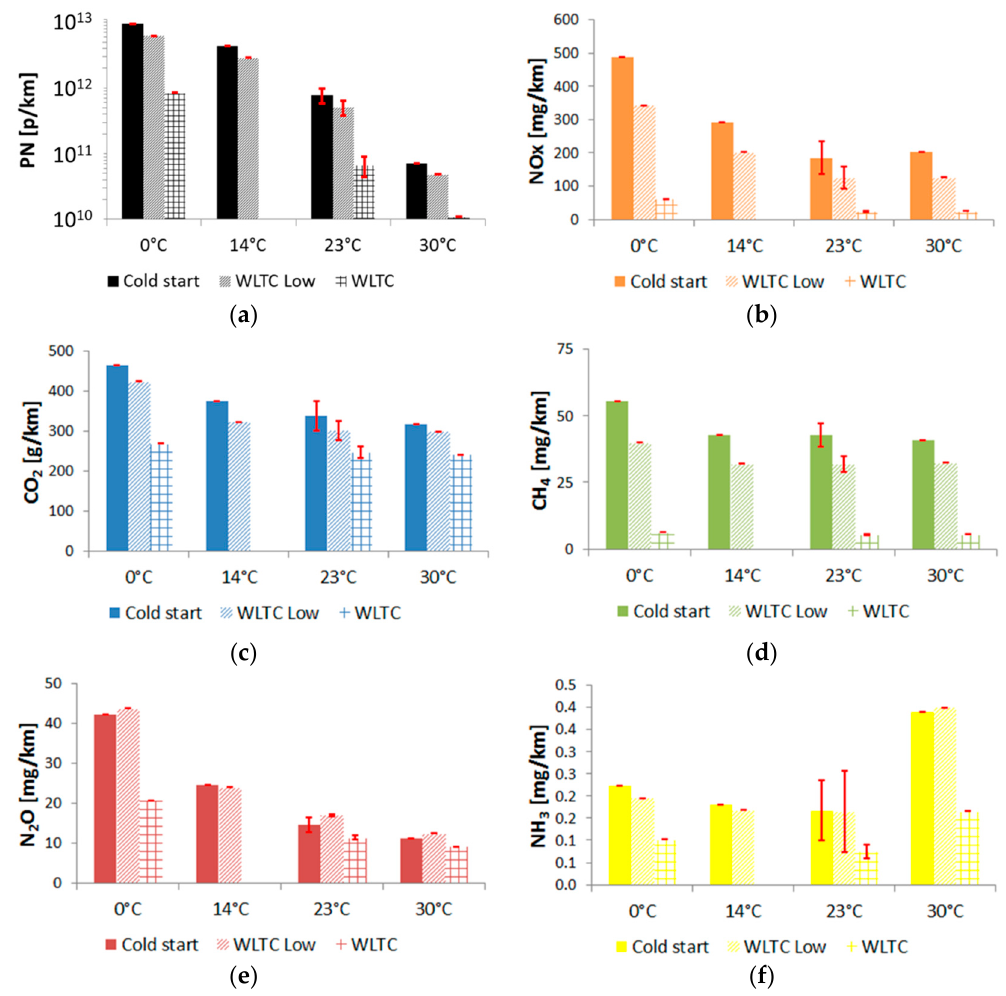
Figure A4. Emissions of PN [p/km] ( a ), NO x [mg/km] ( b ), CO 2 [mg/km] ( c ), CH 4 [mg/km] ( d ), N 2 O [mg/km] ( e ), and NH 3 [mg/km] ( f ) at cold start (first 300 s of the cycle), WLTC Low phase, and complete WLTC, at different laboratory ambient temperatures. The error bars represent the standard deviation. Particle Number (PN) emission as measured with the 23 nm particle counter and gas emissions as measured from the FTIR (Fourier Transform Infrared Spectrometer). WLTC = Worldwide Light-duty Test Cycle. Table A1. Distance-specific emissions of regulated and non-regulated pollutants over the WLTC (Worldwide Light-duty Test Cycle), as measured with FTIR (Fourier Transform Infrared Spectrometer) from the tailpipe at different ambient temperatures.